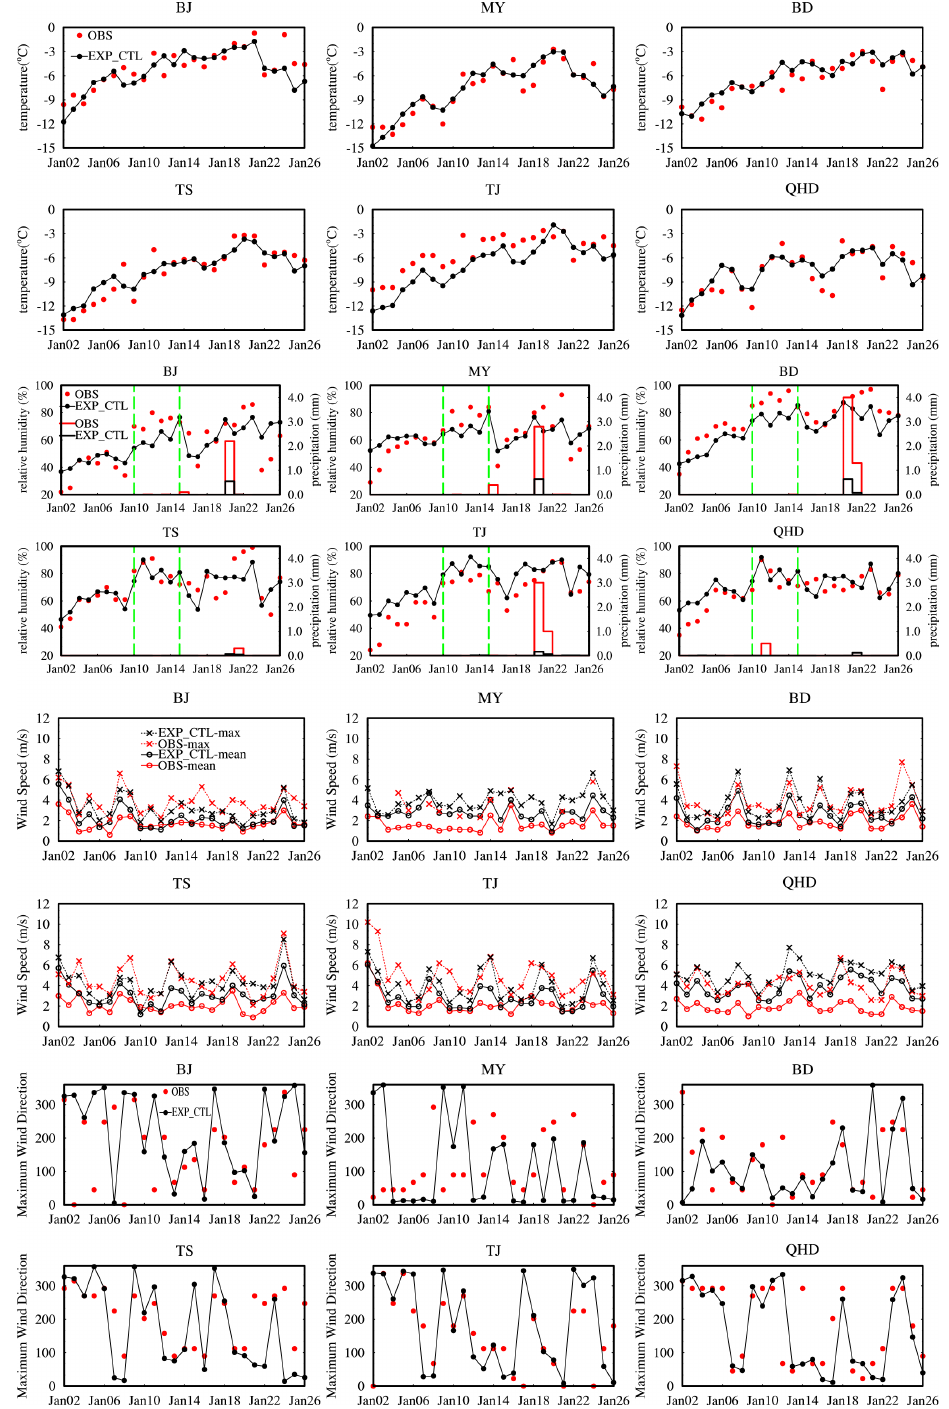
Figure 2. Time series of observed (red) and simulated (black, EXP_CTL) daily-averaged 2m temperature ( ◦ C), daily-averaged 2m relative humidity (%), daily precipitation (mm, bar), daily-averaged 10m wind speed (ms − 1 , solid line), daily 10m maximum wind speed (dashed line), and daily wind direction of maximum wind speed at BJ, MY, BD, TS, TJ, and QHD during 2–26 January